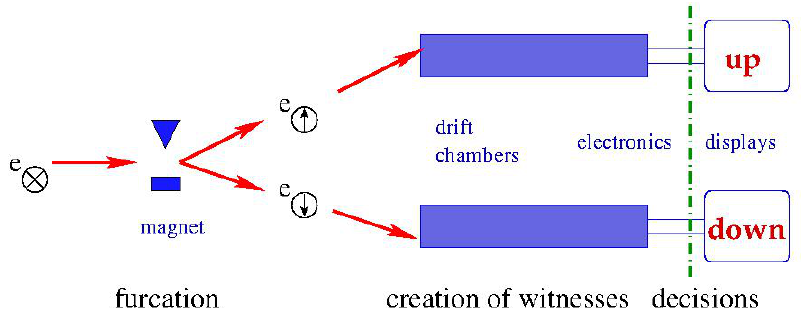
Figure 1. Stern–Gerlach